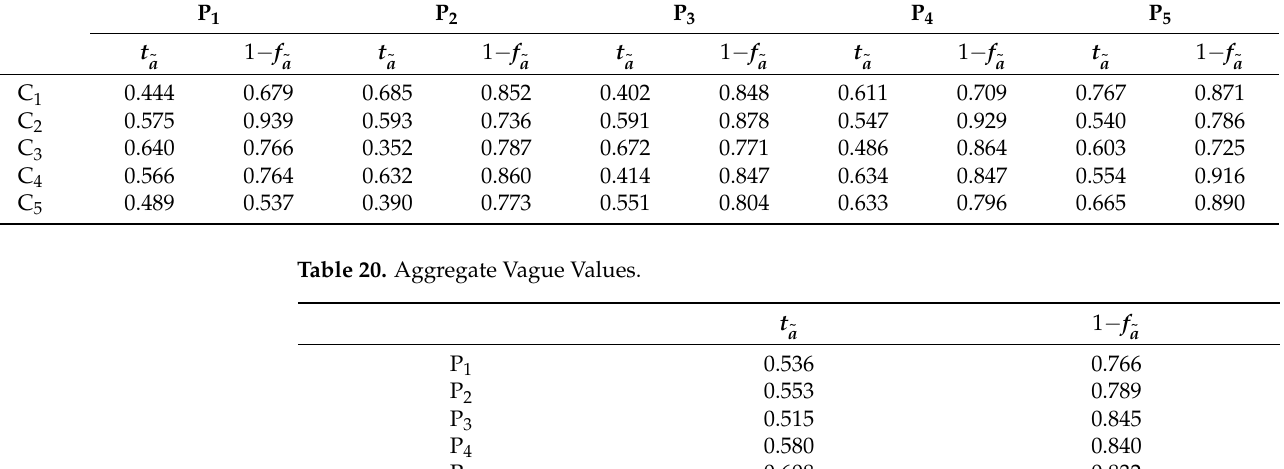
Table 20. Aggregate Vague Values.